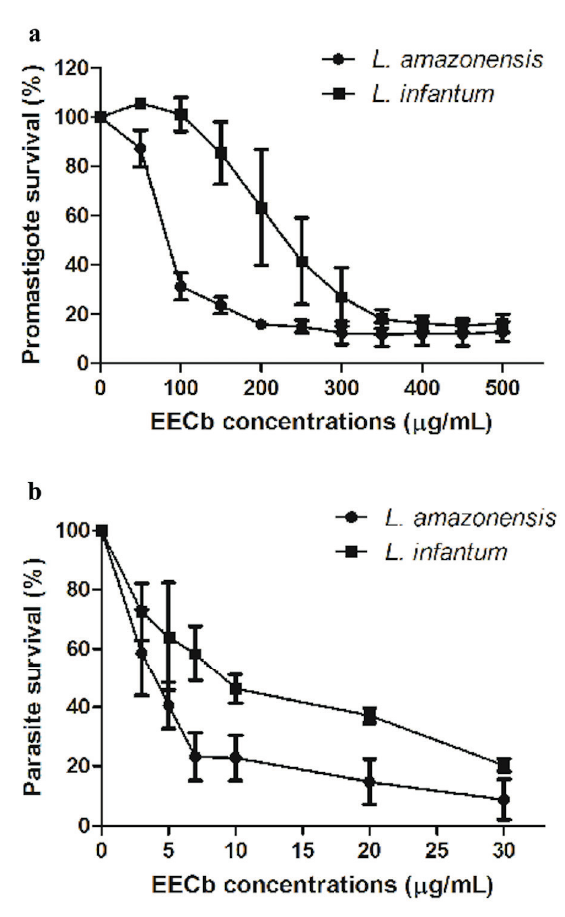
Figure 2. Effect of EECb on L. amazonensis and L. infantum survival. a: Effect of EECb on L. amazonensis and L. infantum promastigotes survival after 24 h of treatment, and b: effect of EECb on L. amazonensis and L. infantum amastigotes survival after 72 h of treatment. Results from three experiments in duplicate (a), and from two experiments in duplicate (b), are shown as percentages and standard errors of survival inhibition, compared to the untreated